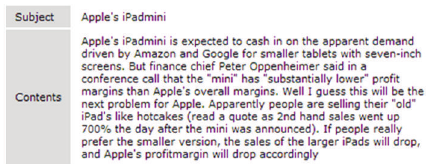
Figure 11: Contents for the “Apple iPad Mini”